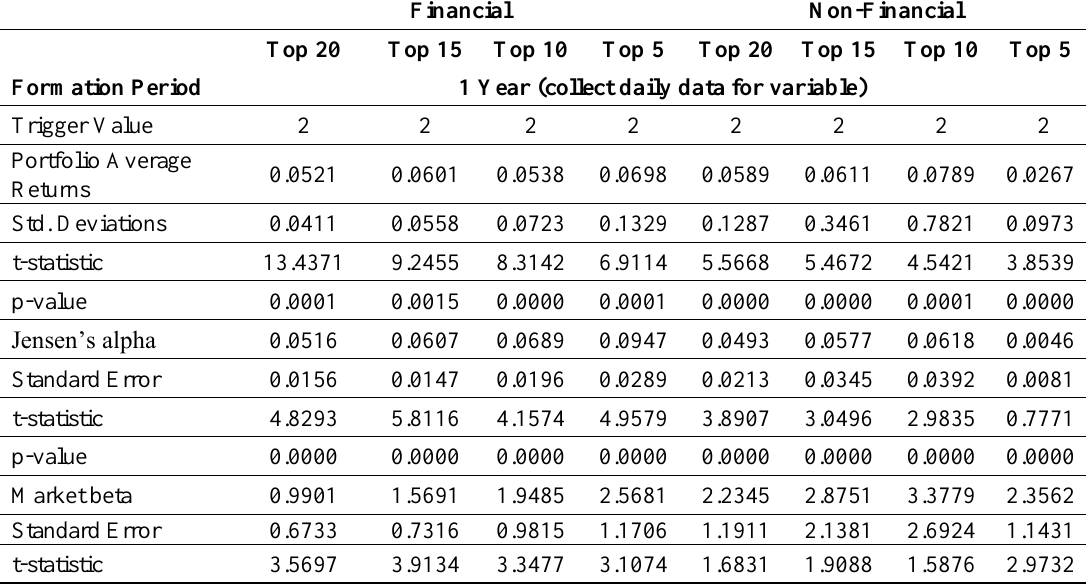
Table.4. Quantitative Analysis of Financial and Non-Financial Sector under Co-Integration Method Financial Non-Financial Formation Period 1 Year (collect daily data for